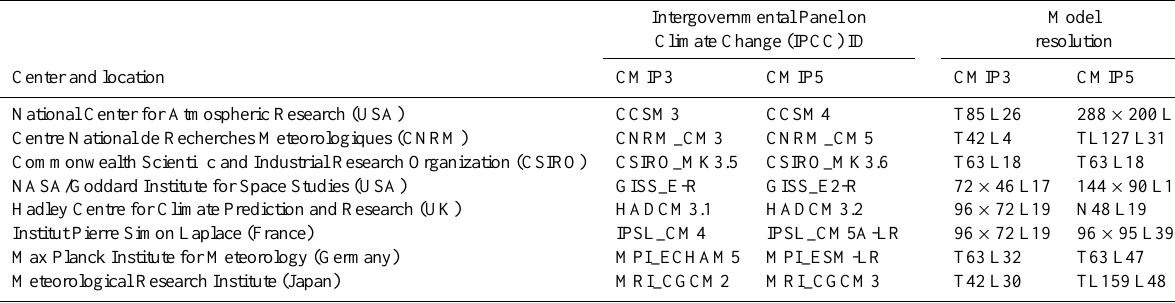
Table 1. Lists of the CMIP3 and CMIP5 model